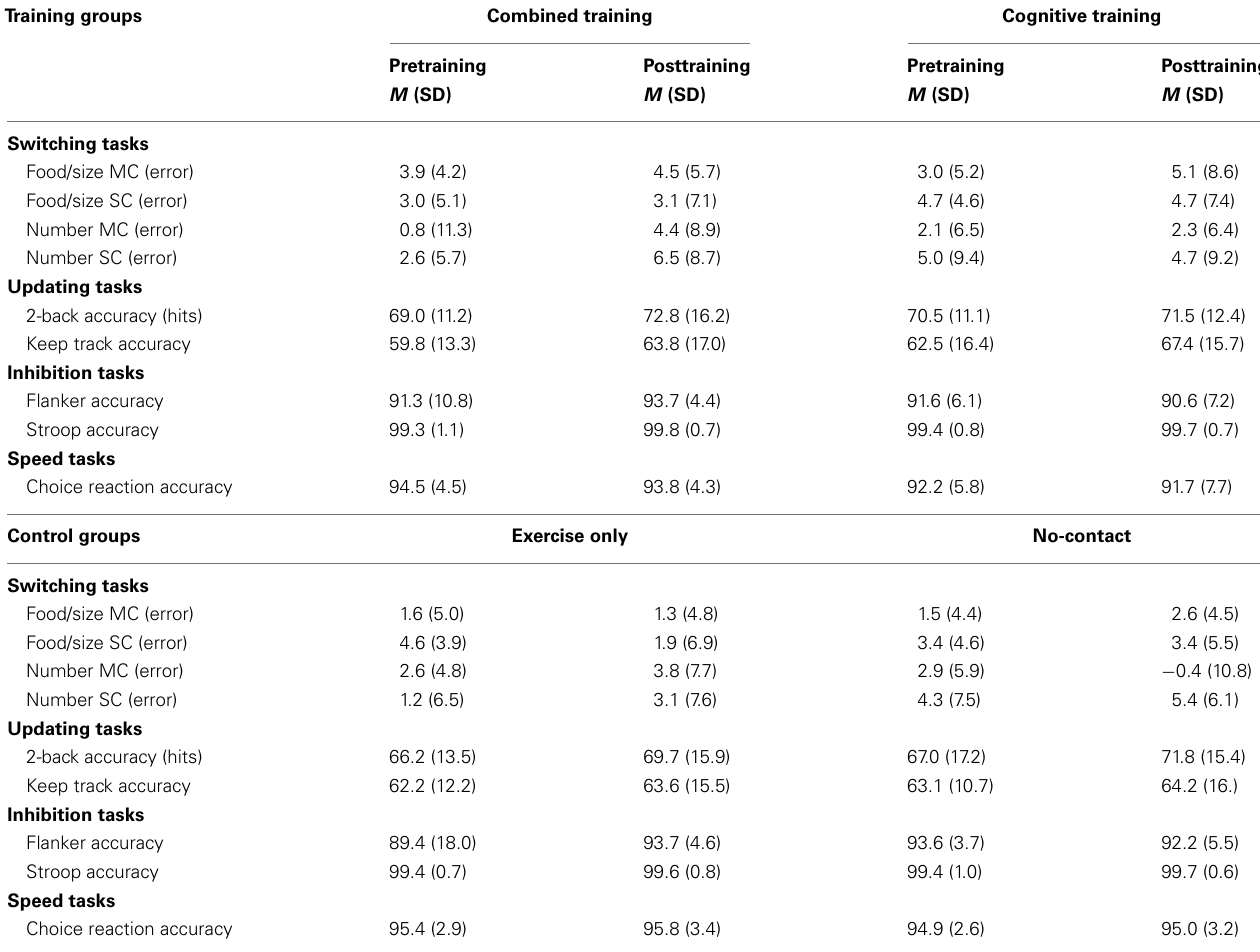
Table 4 | Performance on main dependent accuracy measures (in %) in transfer tasks in the training groups (combined and cognitive training only) and control groups (exercise only and